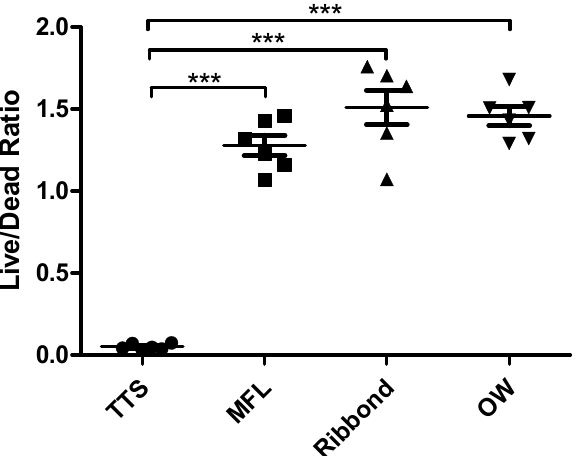
Figure 2. Live/dead ratio plot for the groups tested. Each group is presented by mean and standard error horizontal lines. NiTi orthodontic wire (OW), woven polyethylene ribbon (Ribbond ® ), Titanium Trauma Splint (TTS), and monofilament fishing line (MFL). *** p < 0.0001.